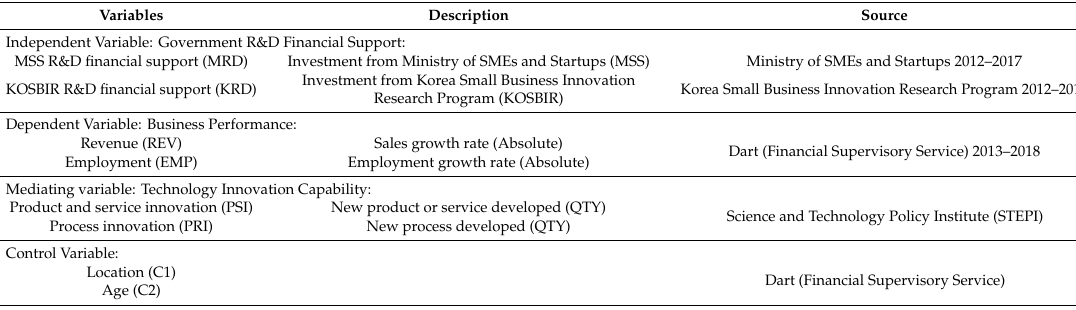
Table 1. Key variables and data